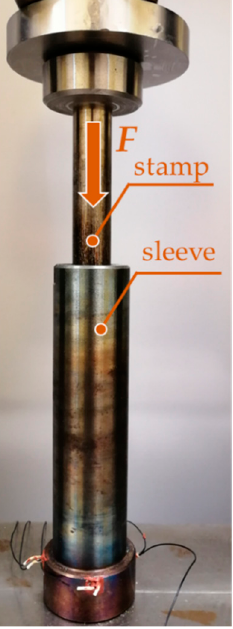
Figure 3. General view of the testing station used in the examination of the compaction process.